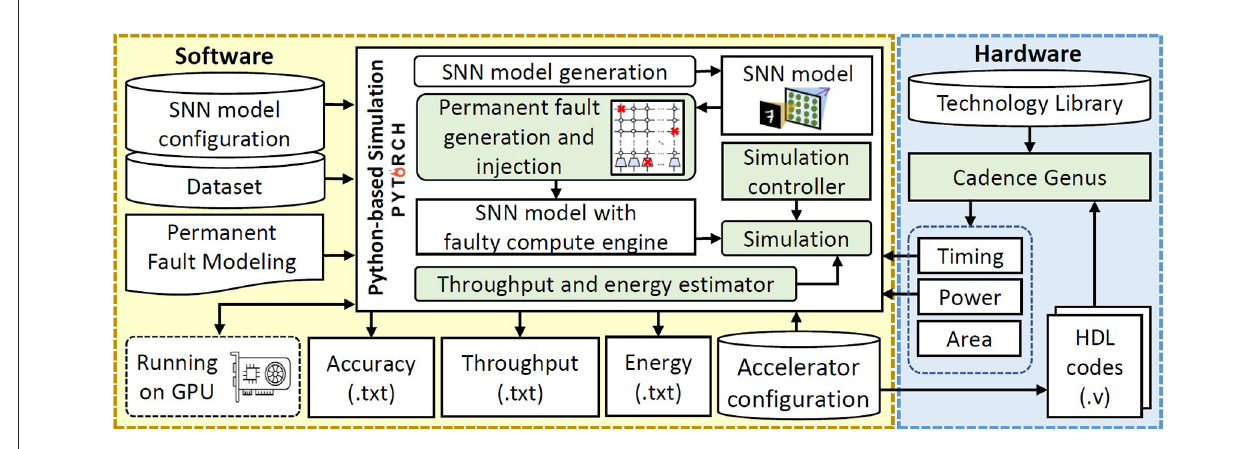
FIGURE12 Overview of the experimental setup and tools flow.